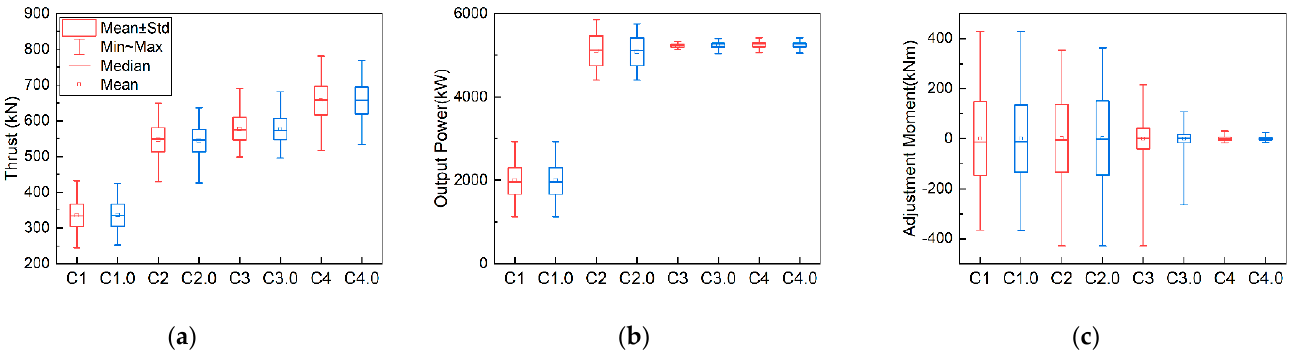
Figure 13. Aerodynamic performance under different wind–wave sea scenarios. ( a ) Thrust; ( b ) Out- put power; ( c ) Adjustment moment.